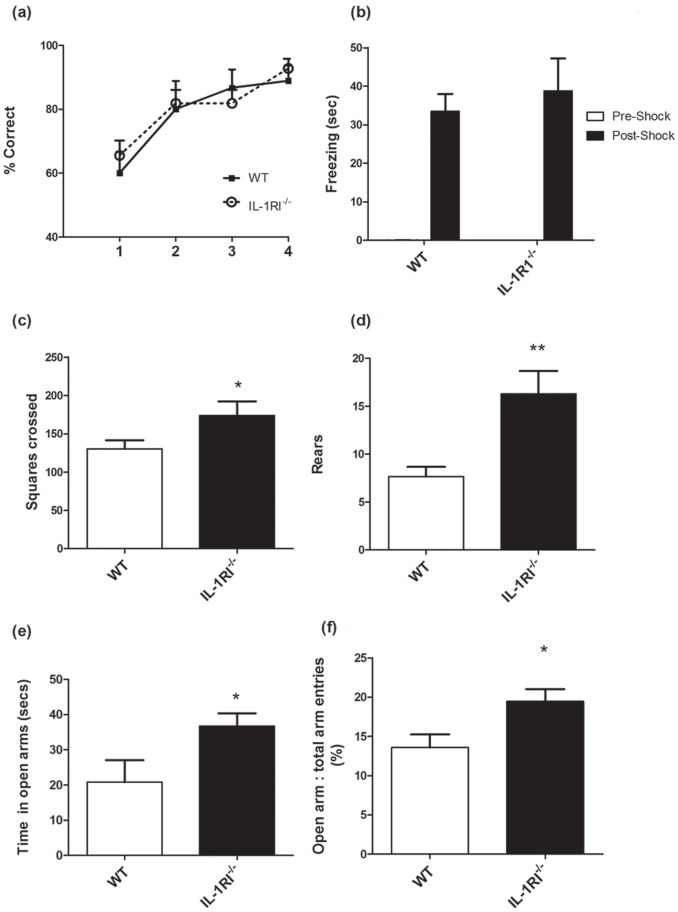
Performance of male IL-1R1−/− mice versus male WT on a battery of tasks.(a) Visuo-spatial reference memory was assessed using the Y-maze across 20 trials (n = 5 per trial block) in male IL-1R1−/− (n = 11) compared to male WT mice (n = 9). (b) The time spent freezing before (too small to be clearly visible), and 48 hours following, 0.4 mA foot shock for male IL-1R1−/− mice and WT mice in the fear conditioning paradigm. (c) The number of squares crossed in 3 minutes in the open field and (d) the number of rears recorded in open field, across 3 minutes (e) the time spent in open arms of the elevated plus maze and (f) entries into open arms as a proportion of total arm entries (for male and females combined). Data are expressed as mean ± SEM and figure (a, b) were analysed by two way repeated-measures ANOVA with strain as between subjects factor and time/block as within subjects factor and all other figures were analysed by one-tailed t-test and significant differences are denoted by ** p<0.001 and *p<0.05.